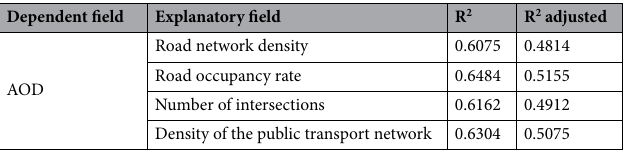
Table 1. GWR model input comparison table.